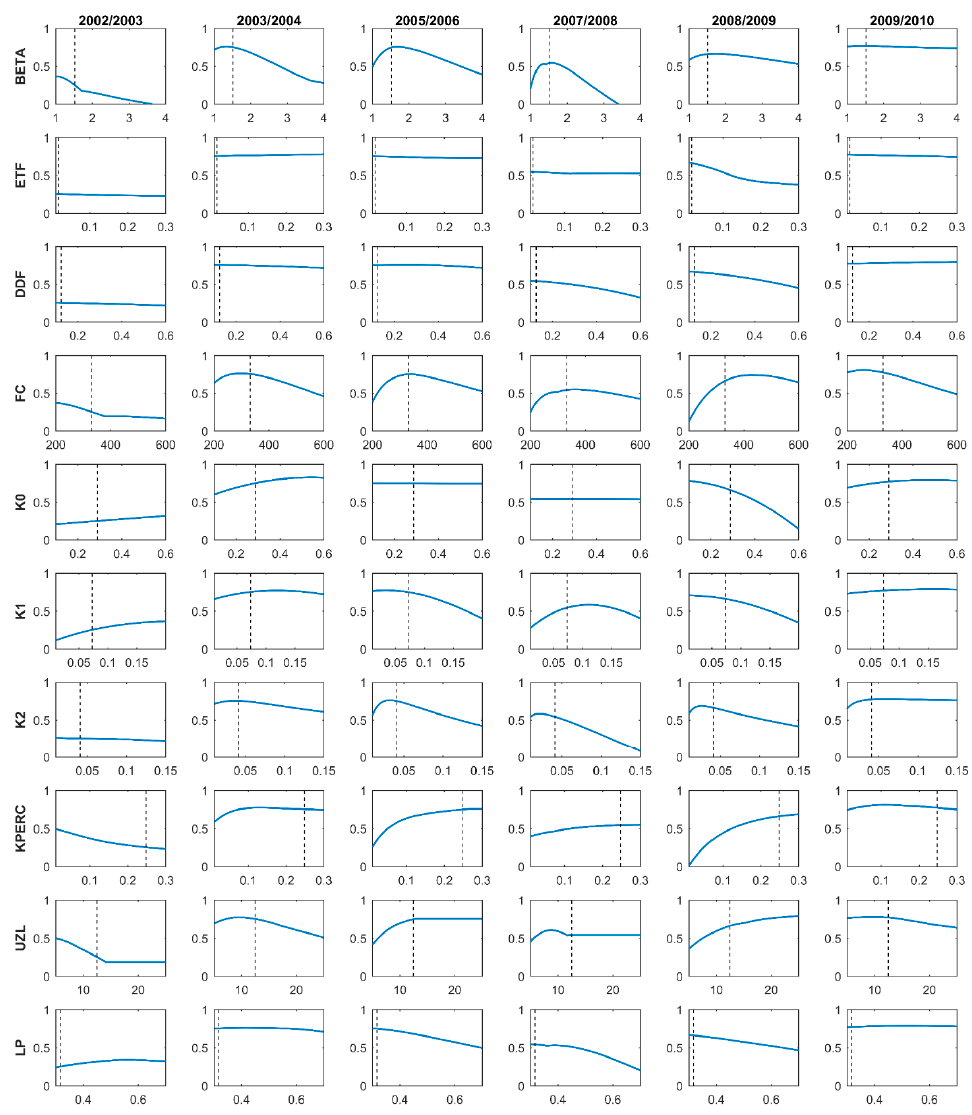
Figure 6. The sensitivity of the model to the changes in parameter values according to the NSE. The dashed lines represent the optimal parameter values obtained after validation.